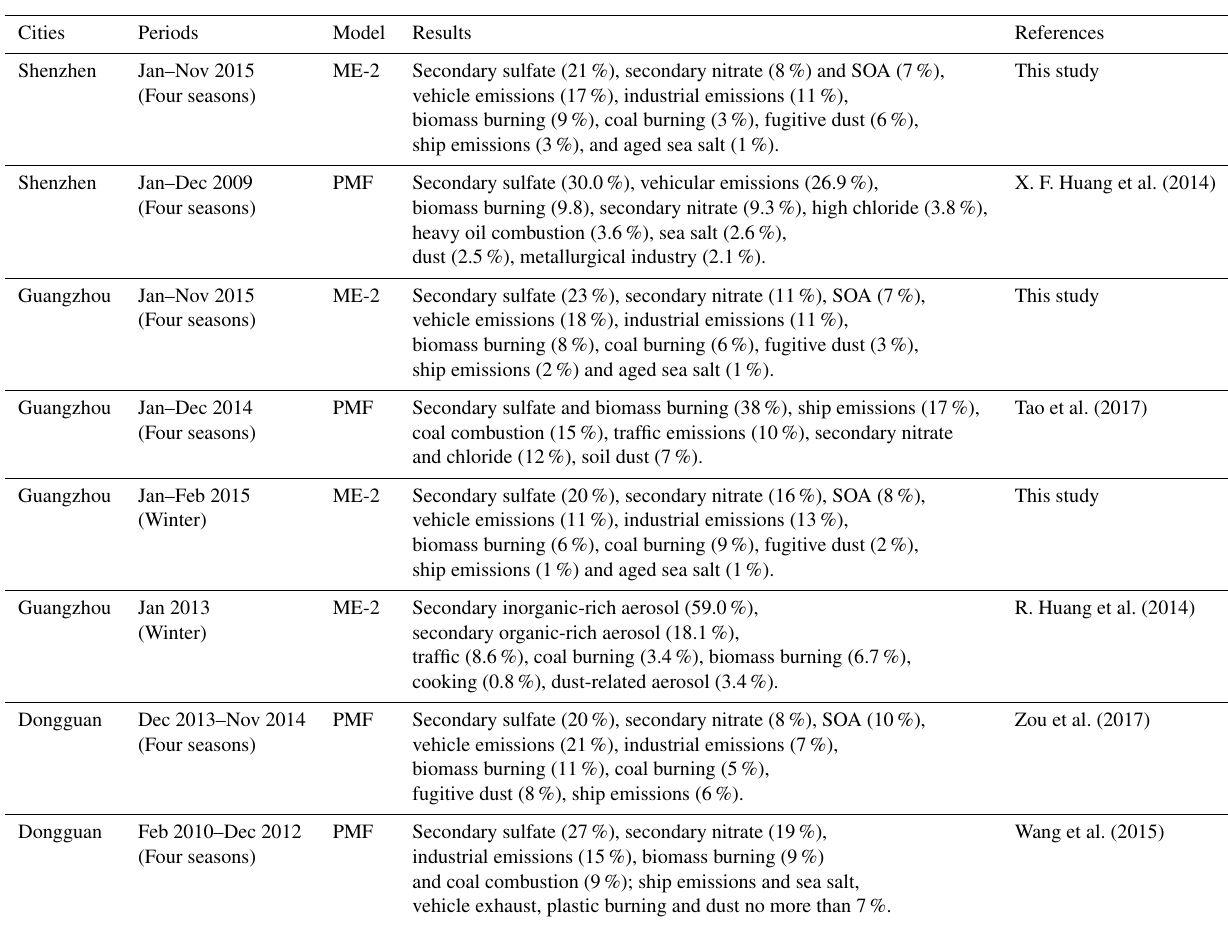
Table 6. Comparison of the results of source apportionment of PM 2 . 5 in the PRD.